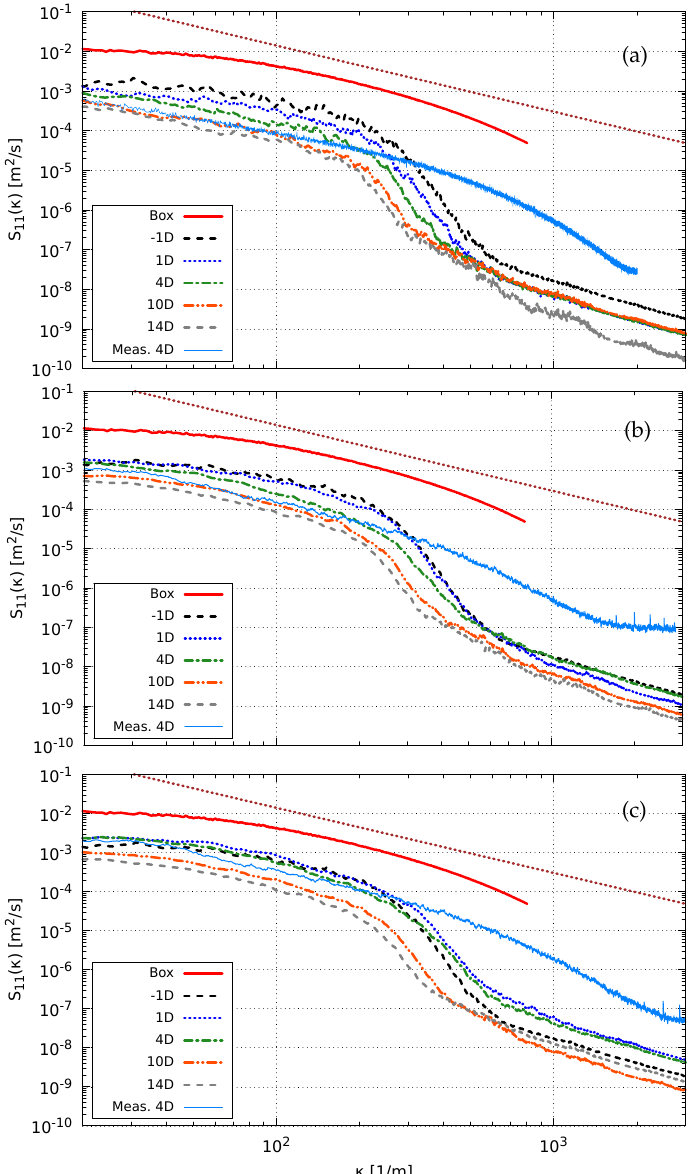
Figure 16. Longitudinal evolution of spectra at centreline using the Ti12 inflow. The results for the free decaying turbulence (without AD) are shown in the top row ( a ), results with disk C T = 0.45 are shown in the middle row ( b ) and results with disk C T = 0.71 are shown in the bottom row ( c ). Spectra computed from measurements are included only for the position x = 4 D . The straight dotted line marks the − 5/3 slope that characterizes the inertial